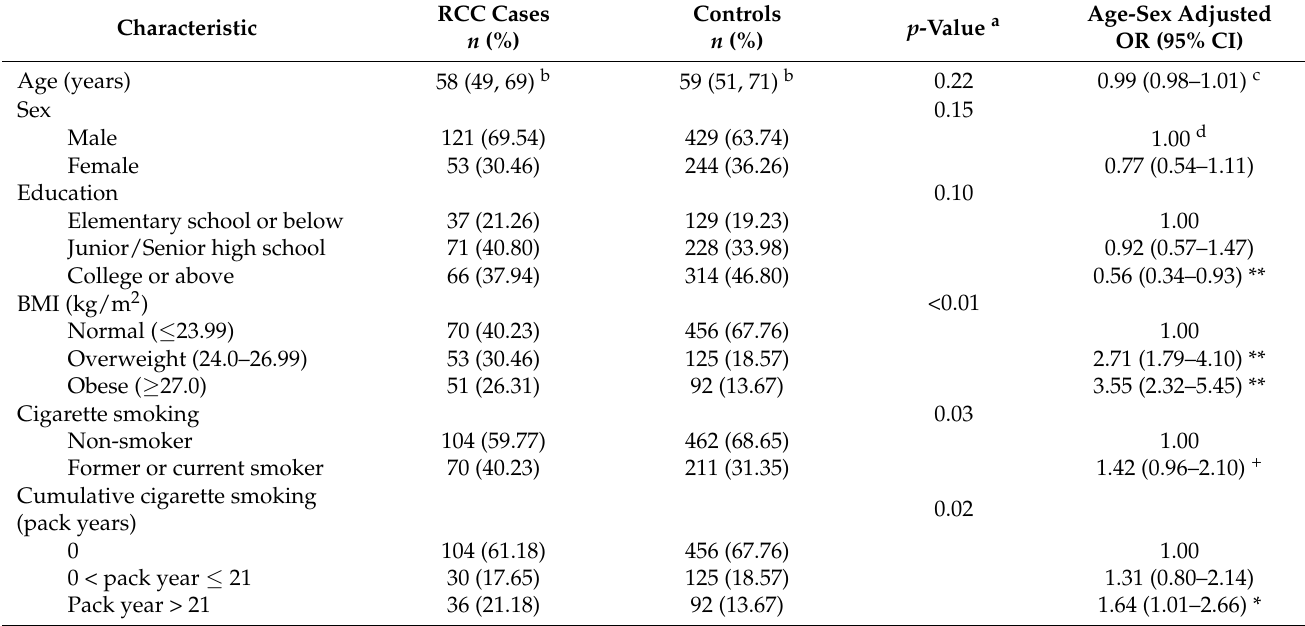
Table 1. Sociodemographic characteristics, lifestyle, and disease histories of RCC cases and non-RCC